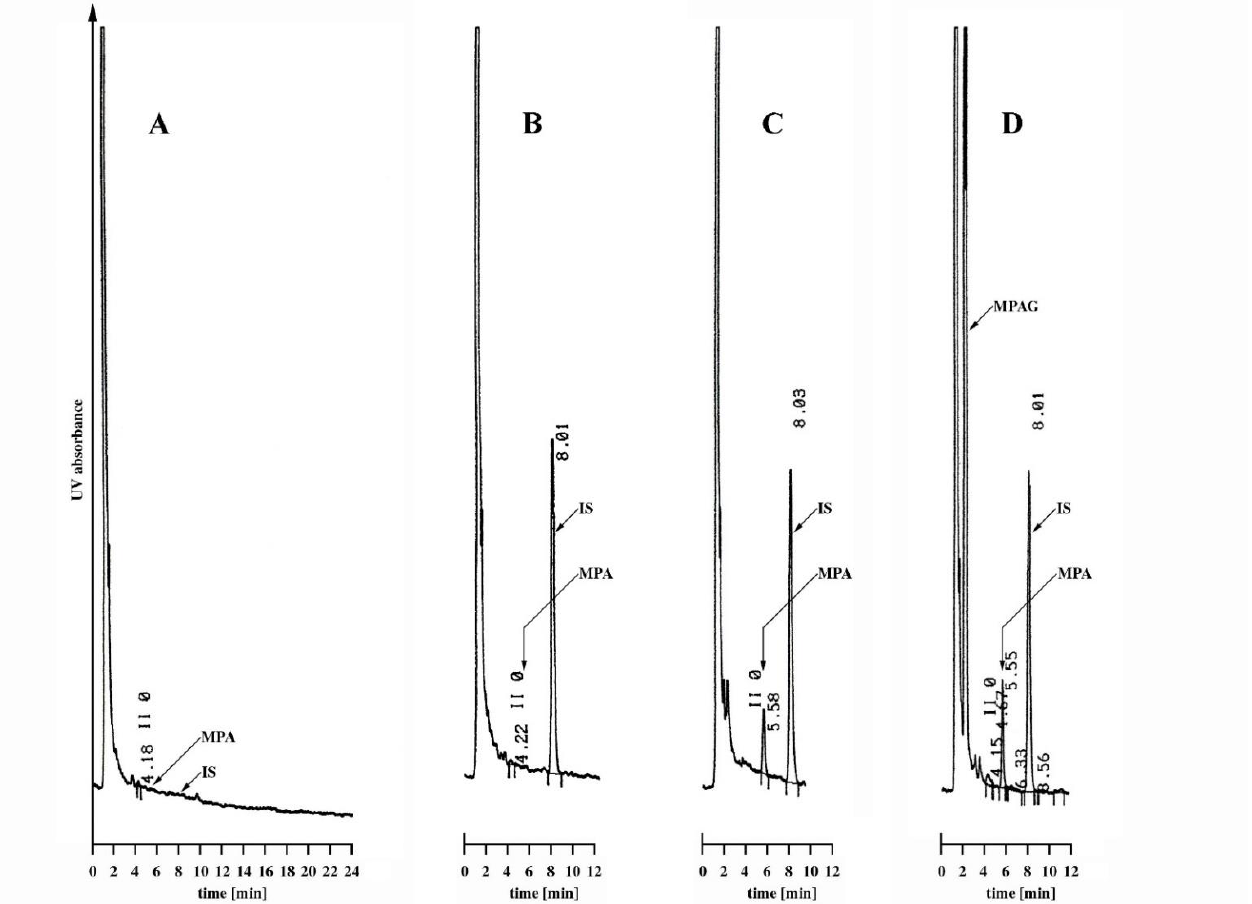
Figure 1. Chromatograms of plasma samples analyzed as described in Materials and Methods (signal attenuation 16): ( A ) drug-free plasma analyzed without IS, ( B ) drug-free plasma, ( C ) drug-free plasma spiked with MPA to obtain the concentration of 1 µg/mL, ( D ) plasma sample taken from the patient treated with MMF containing 1.53 µg/mL of MPA. Peaks: MPAG: ~2.2 min, MPA: ~5.6 min, IS: ~8.0 min.